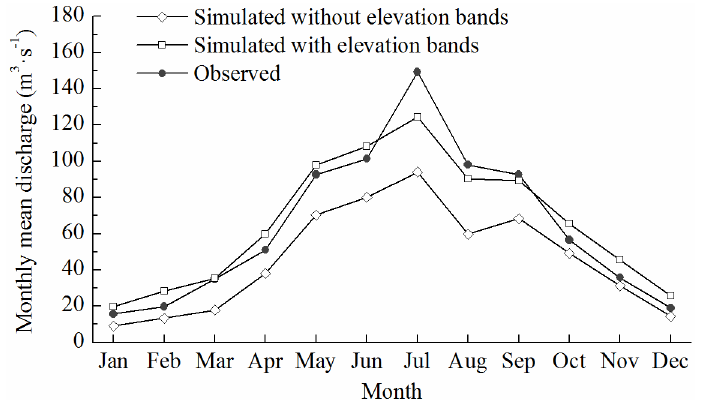
Figure 5. Observed and simulated (with and without elevation bands) river regimes for the Daning River at Wuxi over the period of calibration and validation.